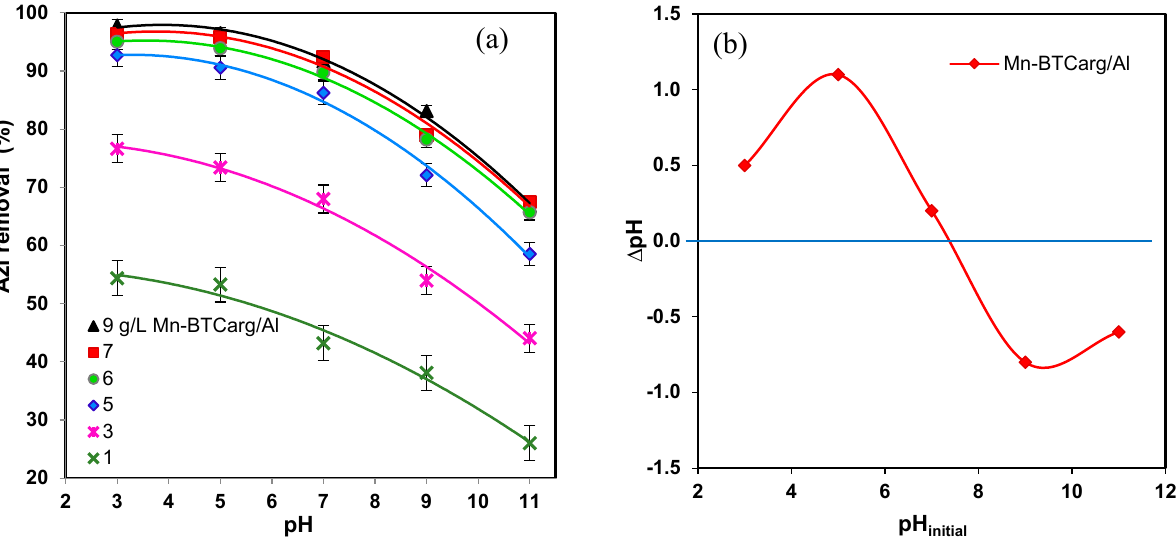
Figure 8. Effects of pH and Mn-BTC arg /Al dosage on the Azi removal ( a ), Azi initial concentration of 0.1 g/L, the H 2 O 2 concentration of 5 g/L and 40 min treatment; The pH zpc of Mn-BTC arg /Al ( b ), Mn-BTC arg /Al dosage of 0.1 g/L.